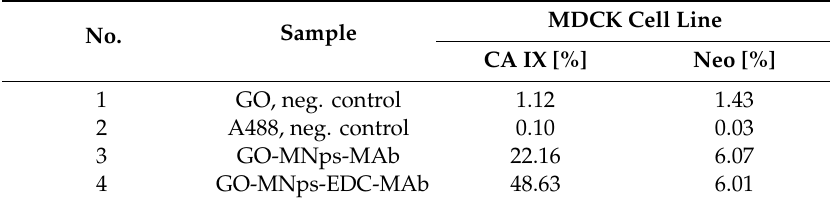
Table 3. Flow cytometry analysis of specific binding to CA IX cells.